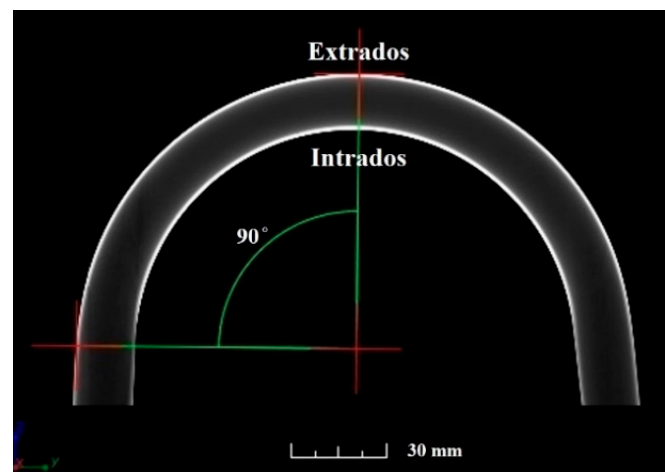
Figure 2. The results of the CT analysis of the U-bend tube. Figure 3a shows the cross-sectional shape of the straight tube obtained through CT analysis and axial settings, and Figure 3b shows the cross-sectional shape of the U-bend tube at the 90 ◦ position shown in Figure 2. In Figure 3a,b, a yellow dotted line is drawn in a circle to determine the distortion rate. The tubing of the intuition showed that no deformation occurred in the fabrication process, as the shape of the U-shaped tube almost coincides with the yellow dotted line, but the bending process for the U-shaped tube caused tensile stress at the extrados and compression stress at the intrados, resulting in higher ovality. In Figure 3b, the horizontal component is unchanged, but the vertical length is shorter than initial length. During CT measurement, the dimensions were measured based on the internal diameter because the X-ray scattering was pronounced on the outer surface, and the internal diameter of the direct tube averaged 16.94 mm. For U-shaped tubes, the width was 0.15 mm less than the straight line, and the vertical width was 0.66 mm less. The measurement error range was about 0.03 mm, and the ovality was about 4.2% in terms of internal diameter.